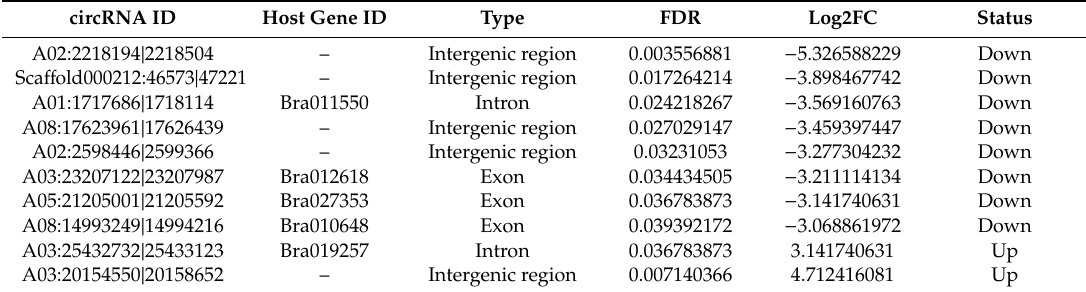
Table 1. Top 10 di ff erentially expressed circRNAs in Bcpol97-05A (sterile line) compared to Bcajh97-01B (fertile line) of Brassica campestris.